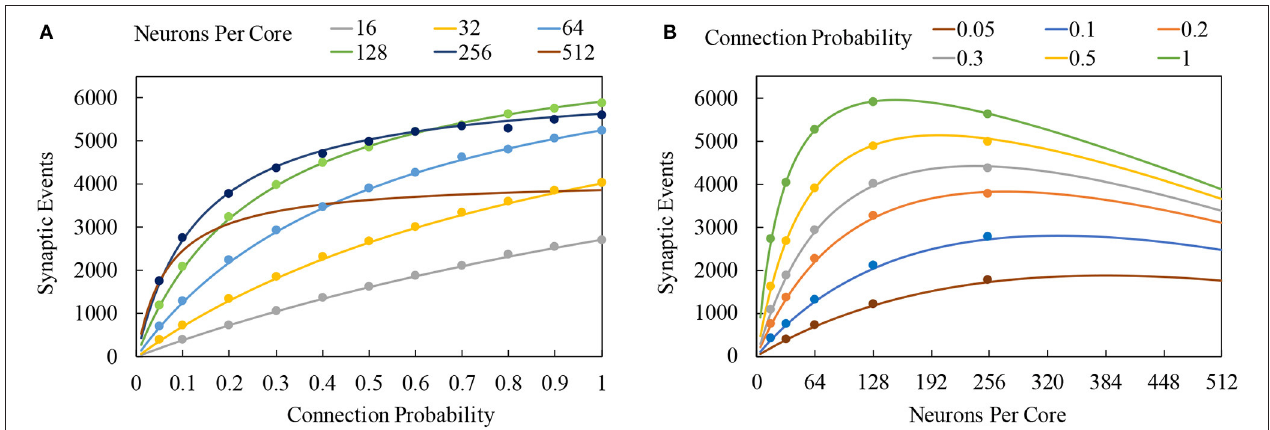
FIGURE 11 | Total number of synaptic events which can be processed between timer events: solid lines represent cost model predictions, while markers show measurements taken from sPyNNaker simulations. (A) Variation of total synaptic events with connection probability for a range of simulated neurons per core. (B) Variation of total synaptic events with neurons per core for a range of connection probabilities.